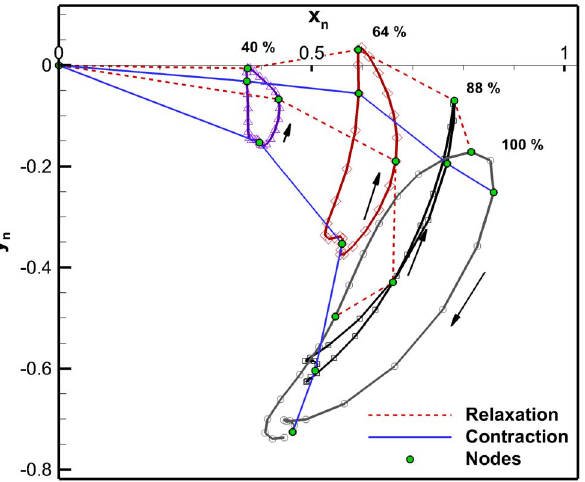
Fig. 12. Four-segment anatomical Fourier model bell trajectory. Bell trajectory at node locations of the four-segment anatomical Fourier model during the second swimming